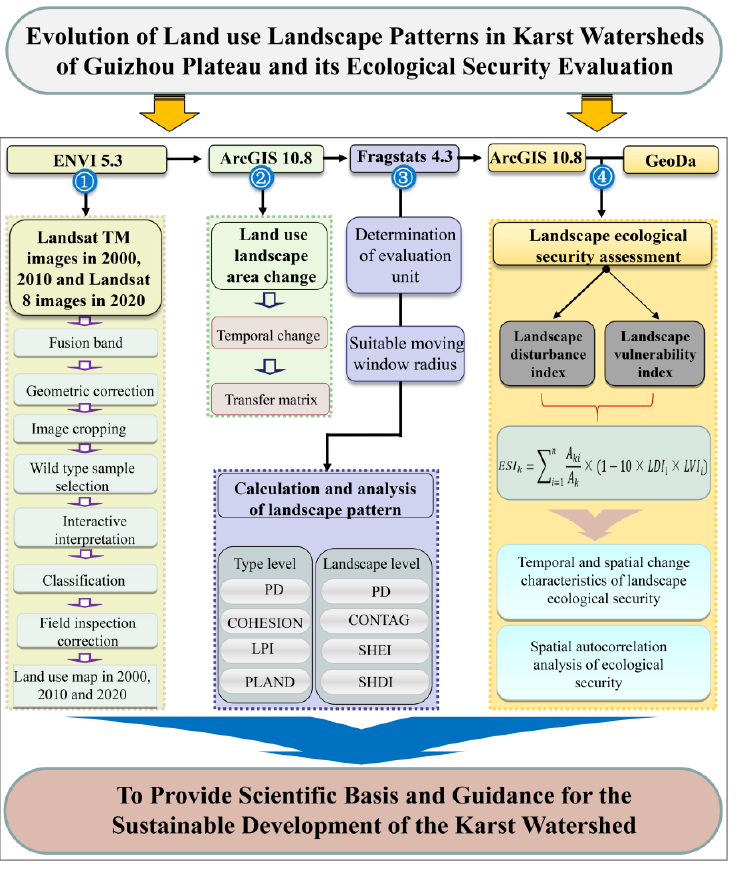
Figure 3. Research